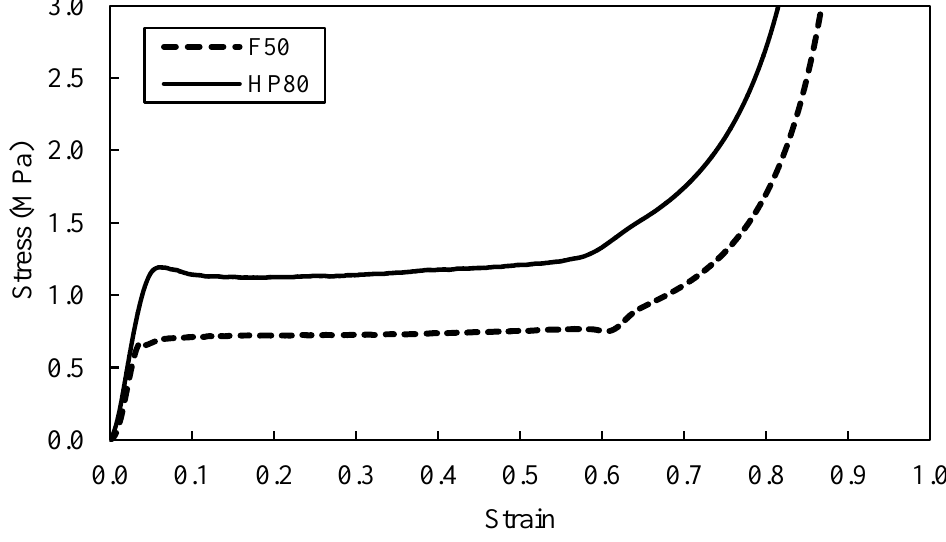
Figure 3. Stress-strain curves of F50 and HP80 foam. Table 3. Compression properties of foam.